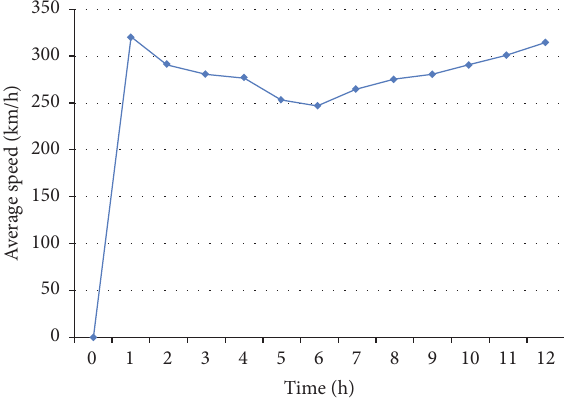
Figure 9: Average speed variation against time.